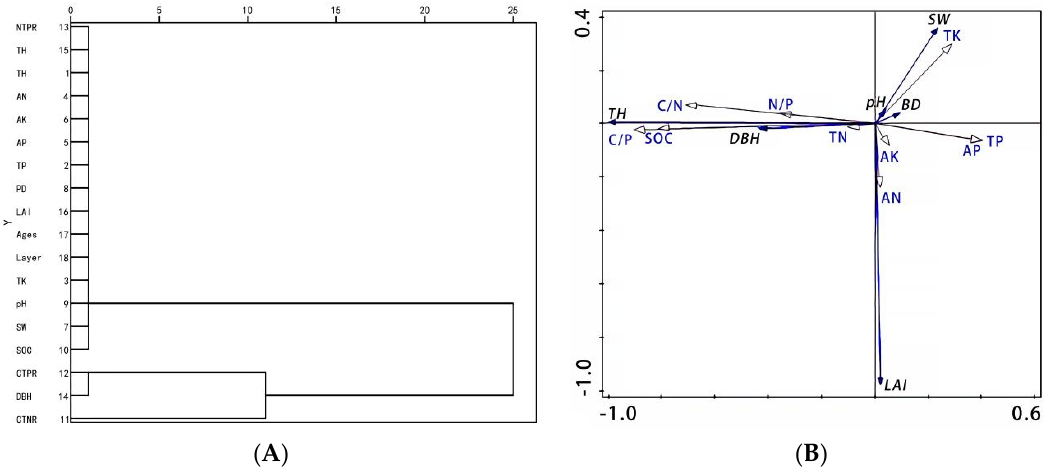
Figure 5. Hierarchical cluster tree ( A ) and redundancy analysis ( B ) of the physical and chemical properties of soil at different forest ages. TN, TP, TK, AN, AP, AK, SW, BD, and SOC represent soil total nitrogen, total phosphorus, total potassium, available nitrogen, available phosphorus, available potassium, water content, bulk density, and soil organic carbon, respectively.